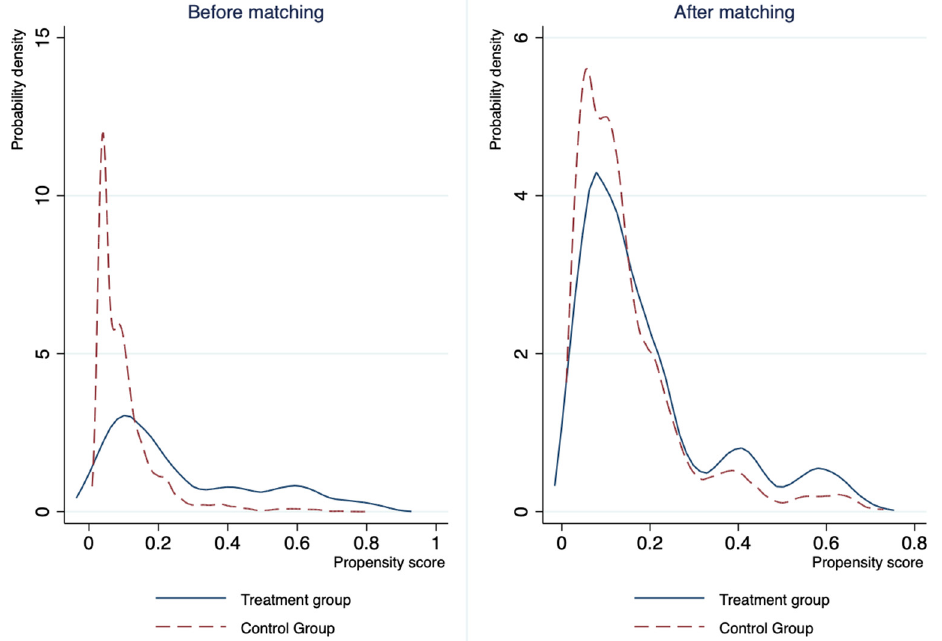
Figure 1. The distribution of propensity